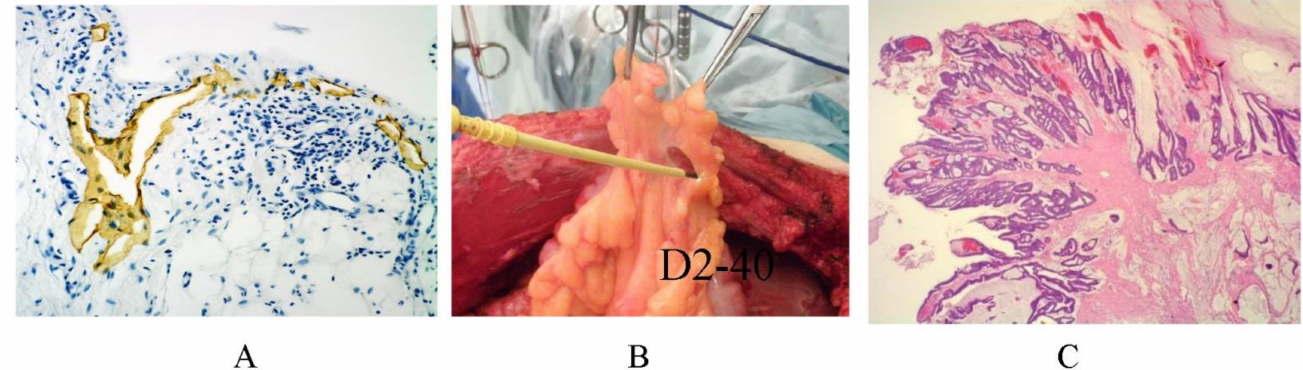
Figure 25. Initial lymphatic vessels are found in the epiploic appendage of the colon ( A ). ( B ) Resection of the epiploic appendage. ( C ) Histologic features of metastasis on the epiploic appendage.